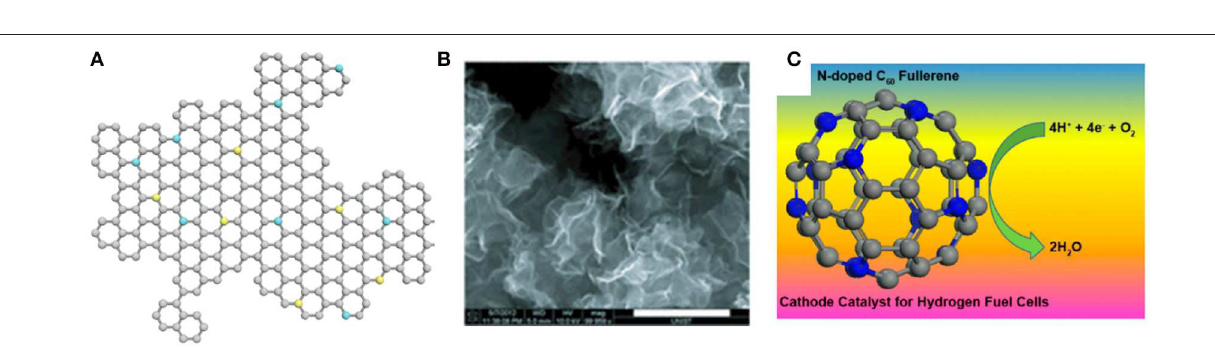
FIGURE 3 | (A) Heteroatom doped graphene. The balls colored gray, blue, and yellow are C, O, N atoms, respectively. (B) SEM image of BCN-graphene. Scale bar is 1mm (reprinted with permission from Jung et al. (2014). Copyright 2014 Wiley-VCH). (C) Schematic electrochemical pathway of nitrogen-doped carbon materials (reproduced with permission. Copyright 2013, American Chemical